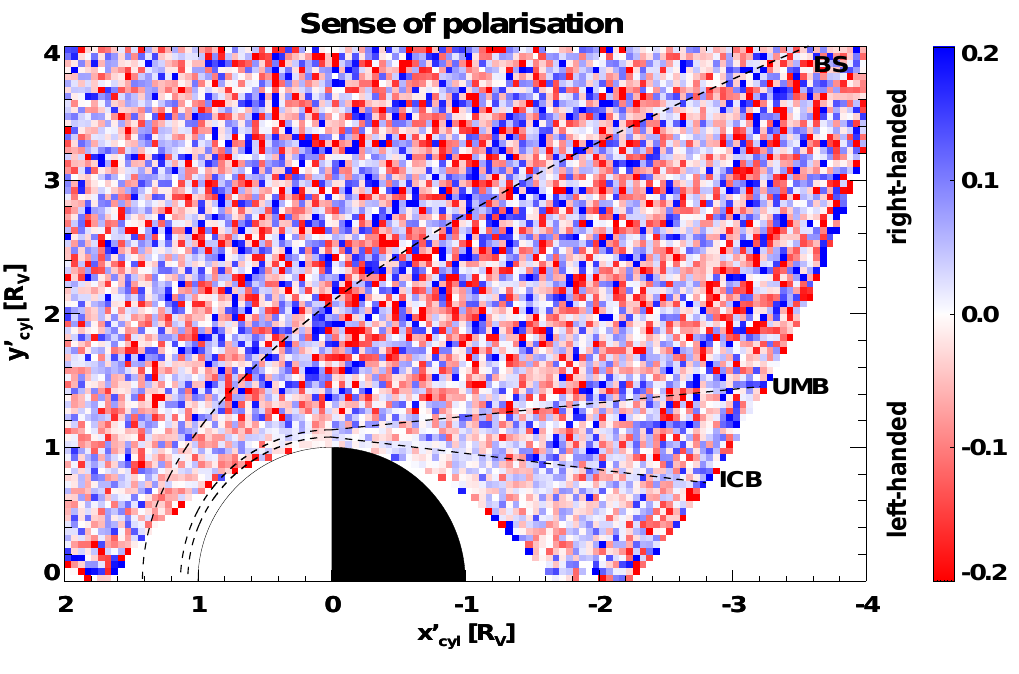
Fig. 6. Average sense of polarisation of the low-frequency magnetic field fluctuations in Venus’ space plasma environment. Blue colours indicate regions of dominating right-handed polarisation and red colours regions of dominating left-handed polarisation. Close to the planet a tendency to less distinct regions of either preferentially left-handed or right-handed polarised waves is observable. The other regions are locally dominated by right-handed or left-handed polarisation, but no connected areas of larger size with a preferential sense of polarisation is